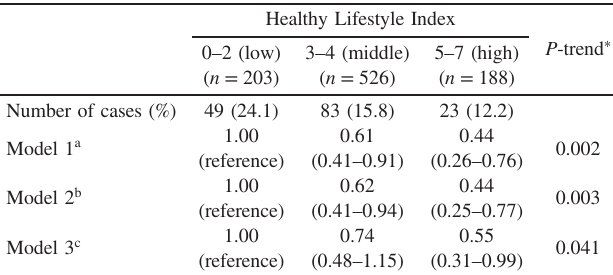
Table 4. The association between alternative versions of the Healthy Lifestyle Index and depressive